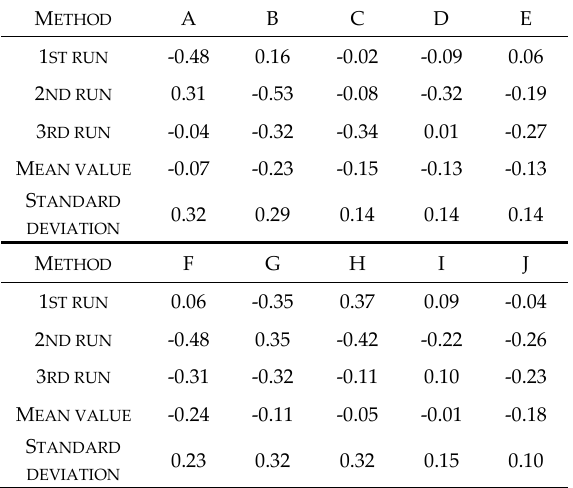
TOTAL ENERGY ESTIMATION RELATIVE